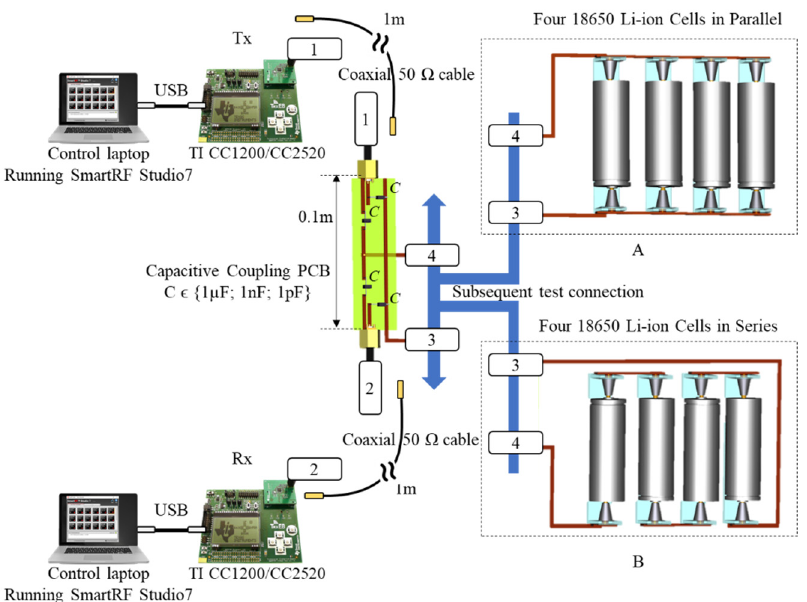
Figure 5. Experimental test setup for 868 MHz and 2.4 GHz communication over the DC bus composed of four Li-ion cells organized in parallel ( A ) and in series ( B ).